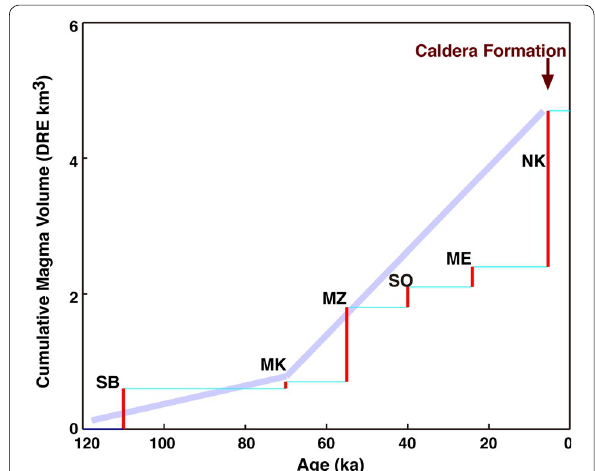
Fig. 5 Cumulative magma volume erupted from Numazawa Vol- cano. A red solid line represents an eruption event. A lilac solid line shows a tendency of the eruption rate. SB deposit; MK Mukuresawa lava dome; MZ = tic deposit; SO Sozan lava dome; ME = NK Numazawako pyroclastic deposit (Yamamoto =